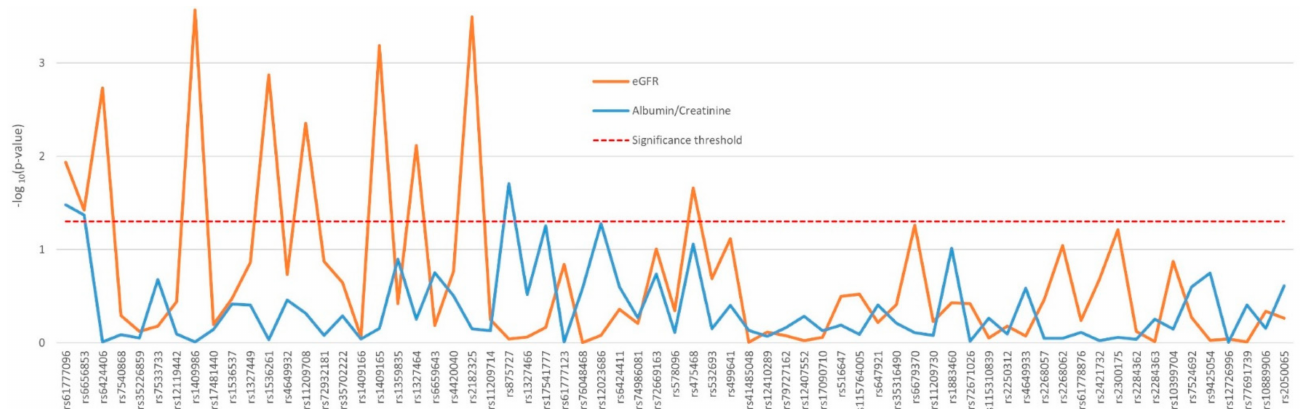
Figure 1. Effect of genetic variability in the PTGER3 gene determined by tag-SNPs on the renal function of nephrosclero- sis patients.